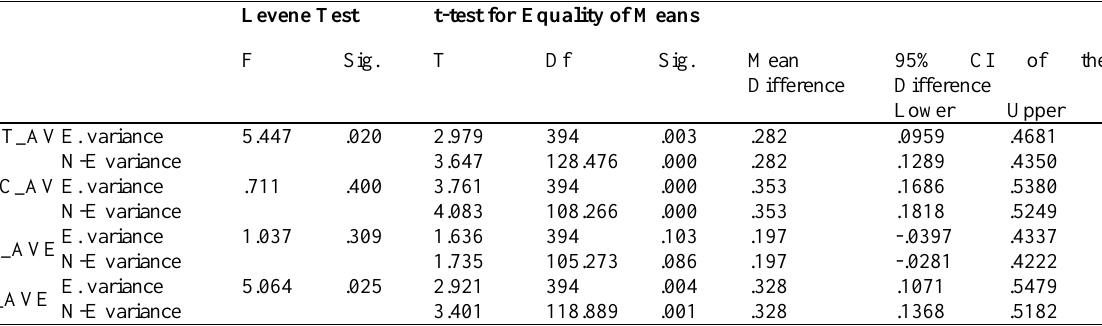
Table 11: Anova Results on IEC and Extra Entrepreneurship Training